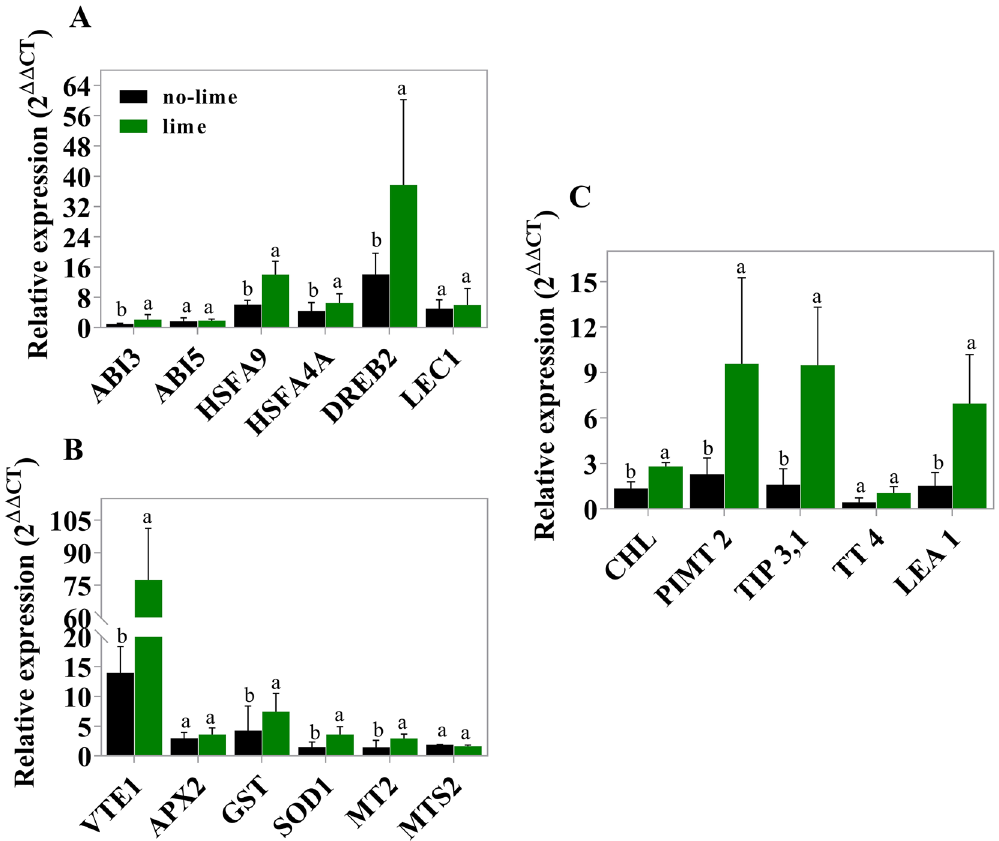
Figure 2. ( A ) Relative expression of transcription factors in the embryonic region of wheat seeds: ABA- insensitive 3 ( ABI3 ), ABA-insensitive 5 ( ABI5 ), heat shock transcription factor A9 ( HSFA9 ), heat shock transcription factor A4A ( HSFA4A ), drought responsive element binding protein 2 ( DREB2 ), and leafy cotyledon 1. ( B ) Relative expression of antioxidants in the embryonic region of wheat seeds with and without lime and stored for different periods of time: ascorbate peroxidase 2 ( APX2 ), superoxide dismutase 1 ( SOD1 ), glutathione s-transferase ( GST ), metallothionein 2 ( MT2 ), mercaptopyruvate sulfur transferase 2 ( MST2 ), and vitamin E deficient 1 ( VTE1 ). ( C ) Relative expression of genes associated with the synthesis of proteins related to longevity in the embryonic region of wheat seeds: chloroplastic lipocalin (CHL), protein-l-isoaspartate methyltransferase 2 (PIMT 2), alpha-tonoplast intrinsic protein ( TIP3, 1 ), transparent testa 4 (TT 4) and EM6 ( LEA 1 ). The same lowercase letters indicate that the seeds in the treatments did not differ by the Tukey test at the 5% level of probability after 60 days of storage. Error bars indicate standard deviation (SD) of three biological